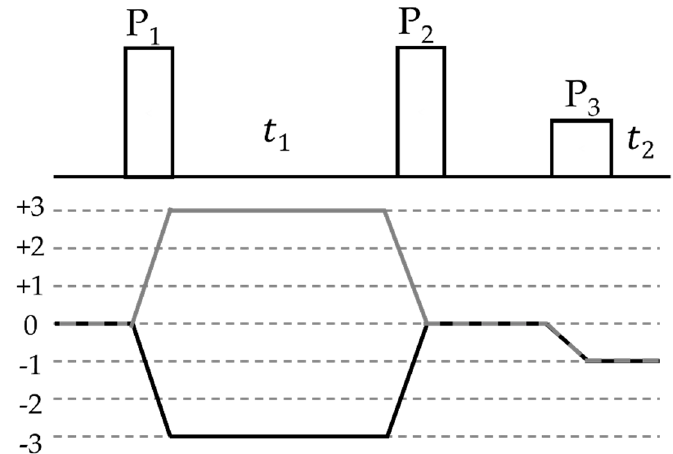
Figure 5. Pulse sequence and coherence path diagram selected via the phase cycling scheme of a triple-quantum MAS-NMR experiment. For spin 3/2 nuclei, coherence orders ranging from +3 to − 3 are possible.